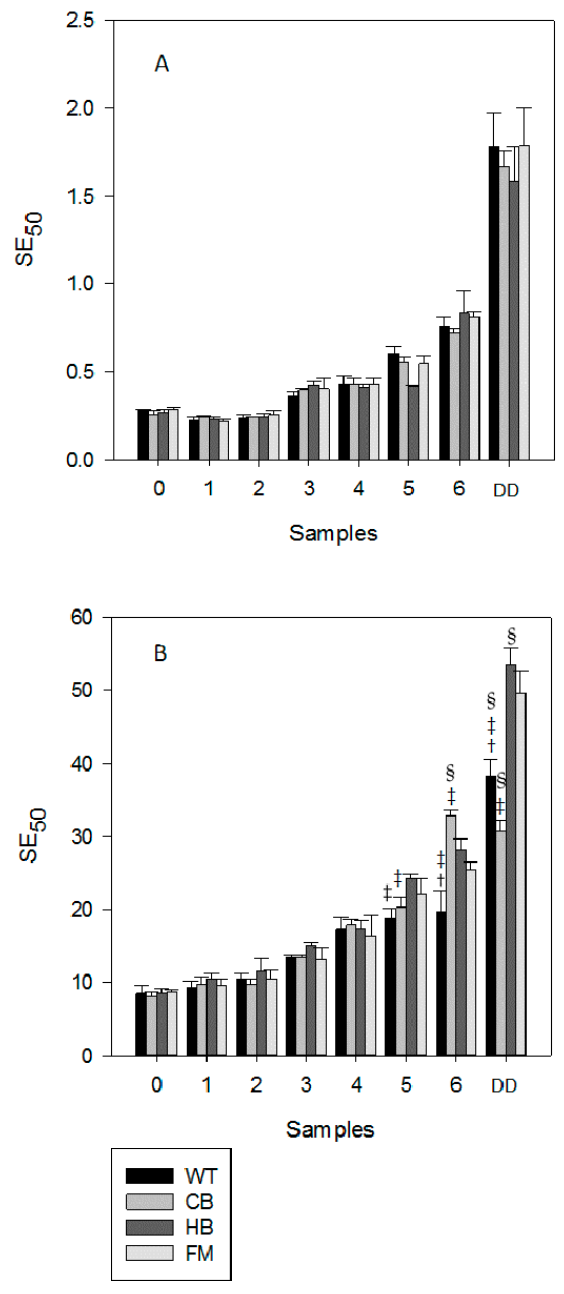
Figure 6. Radical scavenging activity measured in natural (NS, panel ( A )) and blanched (BS, panel ( B )) almond skin before and after simulated human digestion. Values are expresses as mg of sample containing the amount needed to scavenge 50 µ mol of the initial DPPH solution (SE50) and they represent mean ± SD of three different experiments. 0 to 6: gastric samples (see Table 1 for sampling time). DD: sample post in vitro gastric + duodenal digestion. Water (WT), home-made biscuits (HB), crisp-bread (CB) and full-fat milk (FM). † p < 0.01 vs. CB at the same sampling time; ‡ p < 0.01 vs. HB at the same sampling time; § p < 0.01 vs. FM at the same sampling